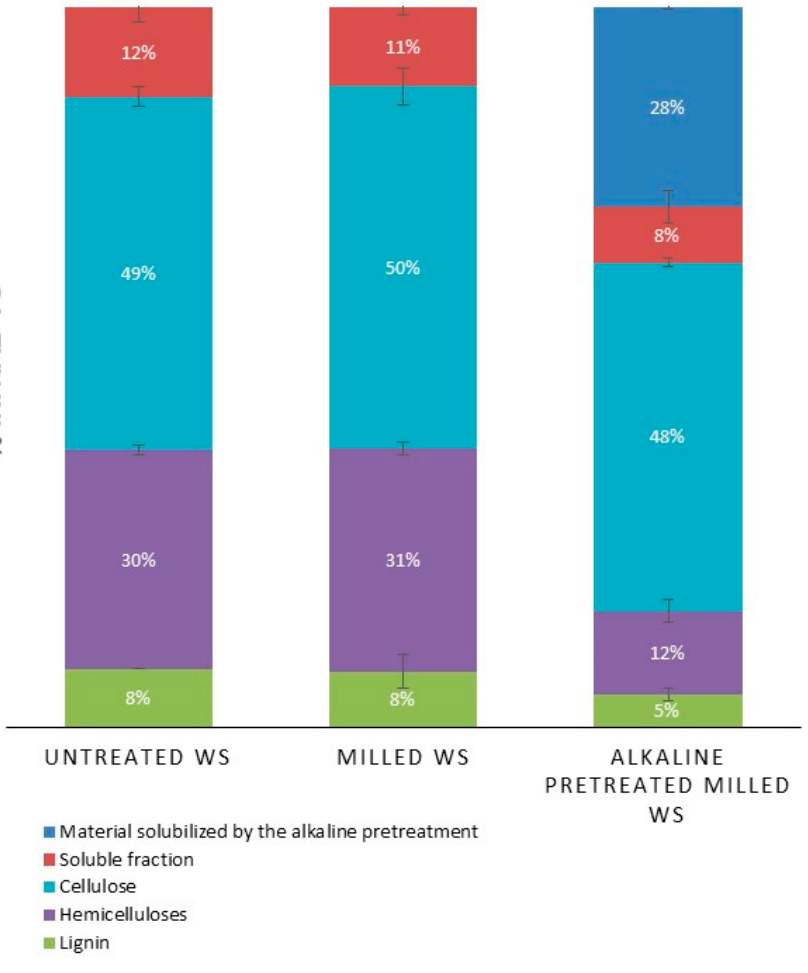
Figure 2. Chemical composition determined by Van Soest fractionation for untreated WS, milled WS, and alkaline-pretreated milled WS, expressed in terms of % initial VS. Values correspond to mean ± standard deviation of measurement performed in duplicate.